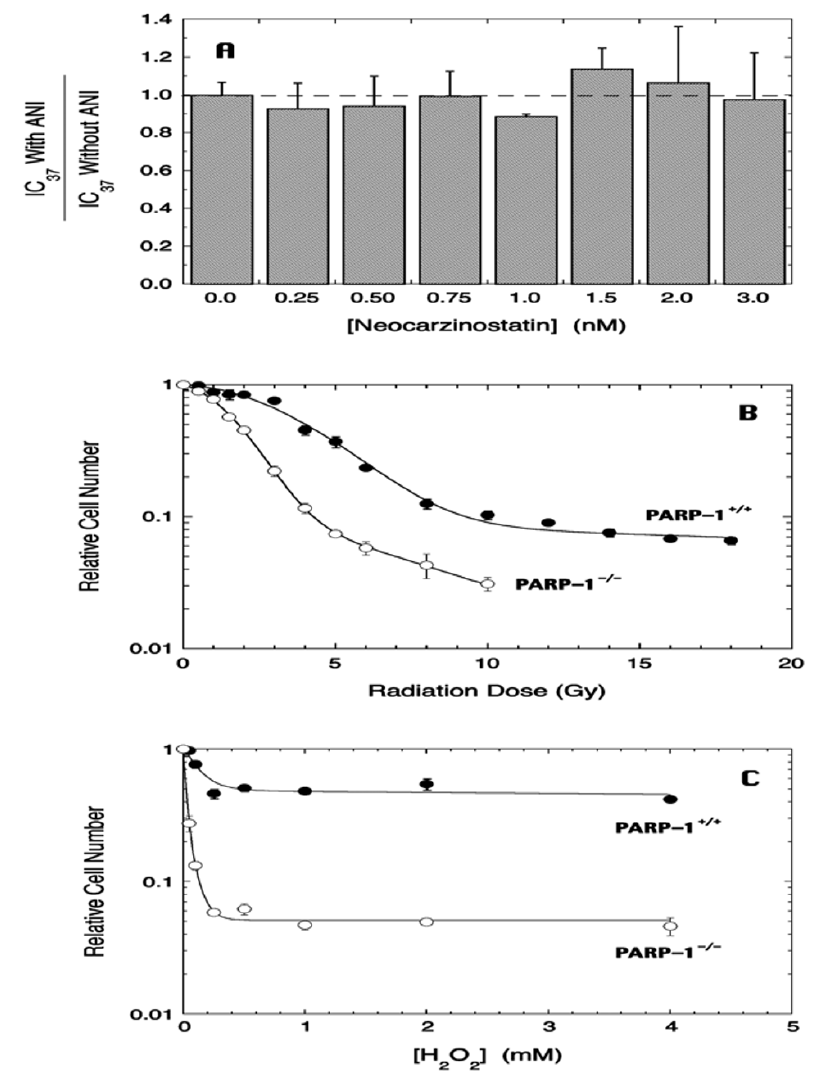
Figure 2 Differential susceptibility of PARP-1 +/+ and PARP-1 -/- 3T3s to γ -rays and H O . A (top). Absence of a significant effect of ANI 2 2 (30 µ M) on the cytotoxic response of PARP-1 +/+ 3T3s to NCS. The results are expressed as the ratio of the mean lethal NCS concentrations (LC ) determined from survival curves in the same way as in Figure 1. B (middle). γ -Ray survival of PARP-1 +/+ 37 and PARP-1 -/- 3T3s. A modified form of the linear-quadratic equation, where D is the radiation dose and (a + b) = 1, was set [6] to take into account the existence of a minor fraction (b) of the cell population experiencing cytolytic cell death at high radiation doses. The values calculated for best fit with the experimental data were: α = 0.134 ± 0.040 Gy -1 , β = 0.168 ± 0.030 Gy -2 for PARP-1 -/- 3T3; α = 0.0258 ± 0.0323 Gy -1 , β = 0.0422 ± 0.0120 Gy -2 for PARP-1 +/+ 3T3s. α represents the contribution to radiation-induced cell death of lethal, non-repairable DNA damage. The quadratic parameter, β relates to unrepaired sublethal damage. Though this is still a matter of controversy [66], β is thought to represent the prob- ability of interaction between separate breaks to exchange chromosomal aberrations [67]. The mean lethal radiation doses (D ), i. e., the doses required to reduce cell survival to 1/e of that in control, are given in Table 1. C (bottom). Cytotoxicity of 37 O against PARP-1 +/+ and PARP-1 -/- 3T3s. The dose-response curves were fitted to a biexponential equation, H 2 2 O concen- with (a + b + c) = 1. c corresponds to the plateau of cell survival at infinite H 2 2 O was cal- tration (0.48 and 0.046 for PARP-1 +/+ and PARP-1 -/- 3T3s, respectively). The initial slope of the cells' response to H 2 2 culated at 2.6 and 25.8 mM -1 for PARP-1 +/+ and PARP-1 -/- 3T3s,